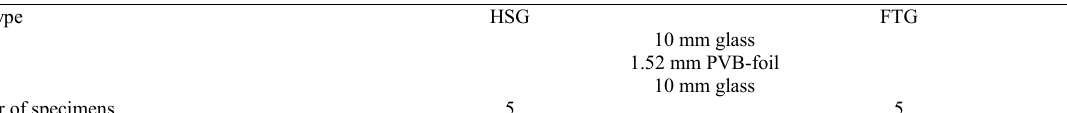
Fig. 3 Dimensions of the beams.